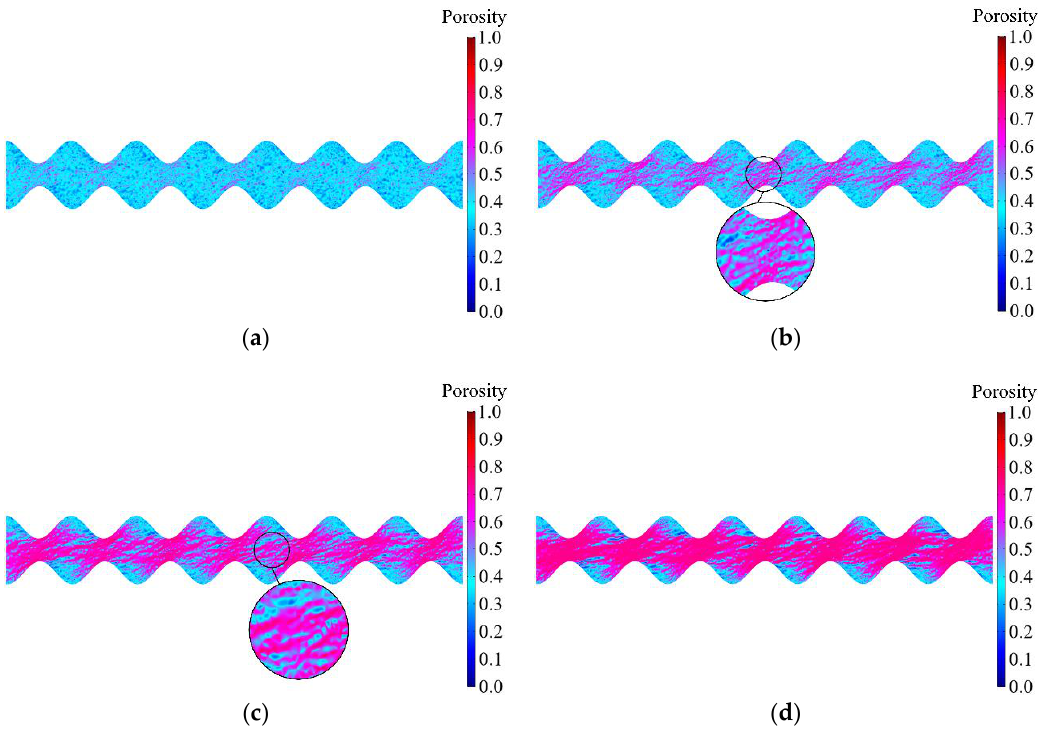
Figure 10. The porosity contours at different times: ( a ) 20 s; ( b ) 40 s; ( c ) 60 s; ( d ) 80 s.